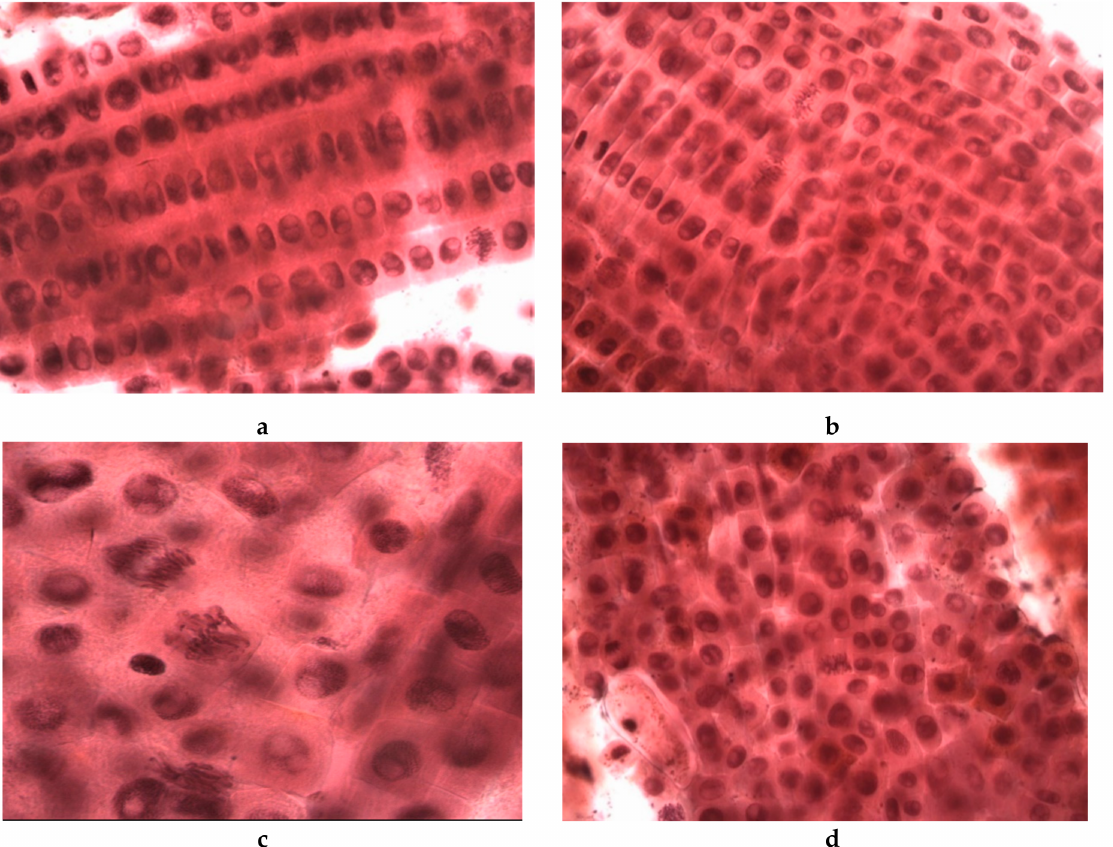
Figure 8. ( a ) Telophase with slight tropokinesis observed in rootlets treated with compound 13 (conc. 1000 µ M). ( b ) Normal metaphases, telophases, and slight tropokinesis observed in rootlets treated with compound 17b (conc. 10 µ M). ( c ) Dis- organized metaphases or in tropokinesis observed in rootlets treated with compound 17a (conc. 10 µ M). ( d ) Normal telophase and metaphases as well as in tropokinesis observed in rootlets treated with compound 17d (conc. 100 µ M). All photomicrographs were obtained with a 40 ×